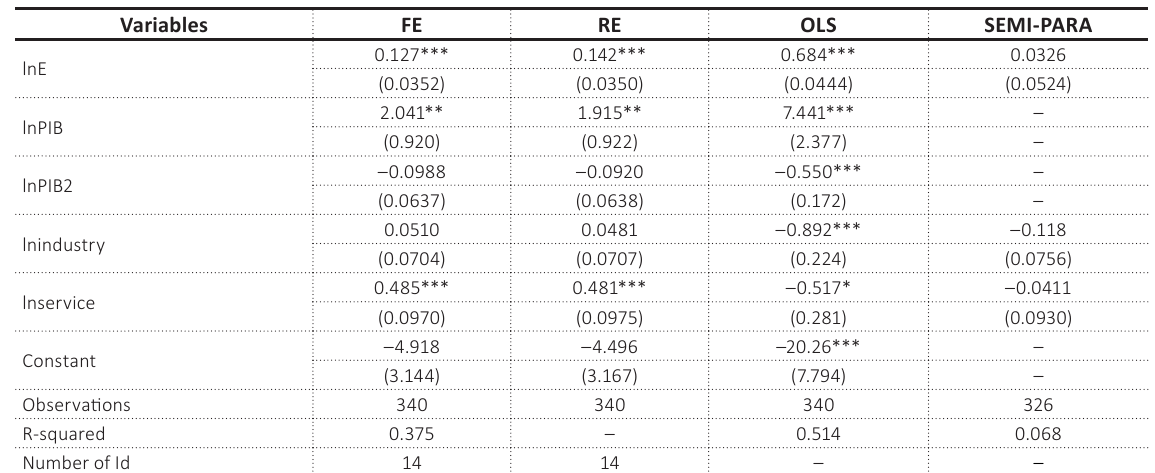
Table 5. Estimate with N02